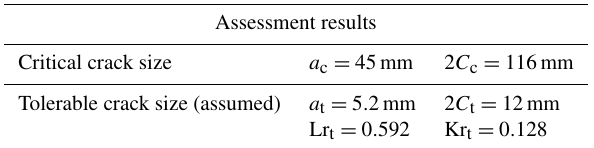
Table 6. Results for crack growth in HAZ and in Air